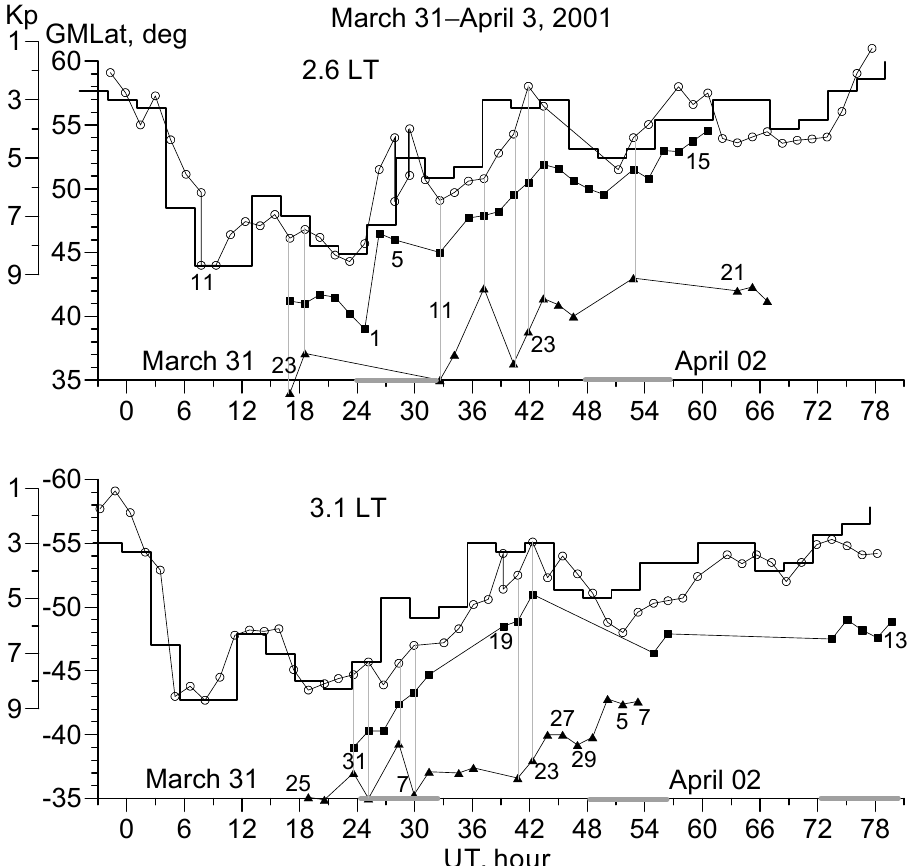
Figure 1. The variations in the MIT (circles), RIT (squares), and LLT (triangles) position from 31 March to 3 April 2001, at 2.6 LT in the Northern hemisphere and 3.1 LT in the Southern hemisphere. Broken line depicts the Kp-index changes. Vertical lines indicate cases with three troughs. Horizontal thick line segments on the X-axis show longitudes with a weak geomagnetic field. The CHAMP passes under consideration are marked by the numbers. The time is counted from 00 UT on 31 March.